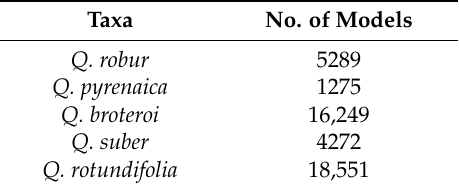
Table 5. Number of models where coefficients signals were